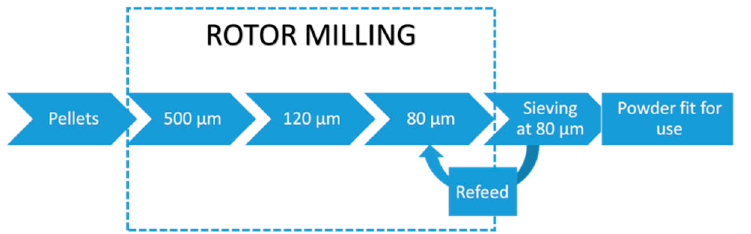
Figure 4. Schematics of the rotor milling process with the three-step refinement. After milling, the powders are sieved and the redundant powder is re-fed to the rotor miller for further refinement.